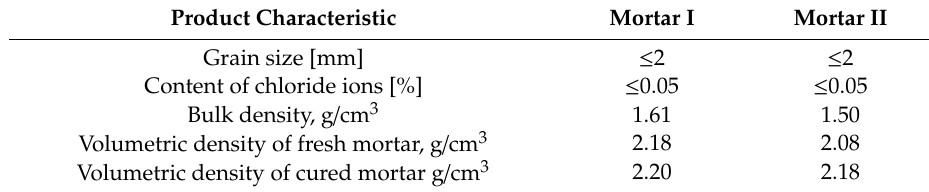
Table 3. Basic identification characteristics of the tested PCC repair